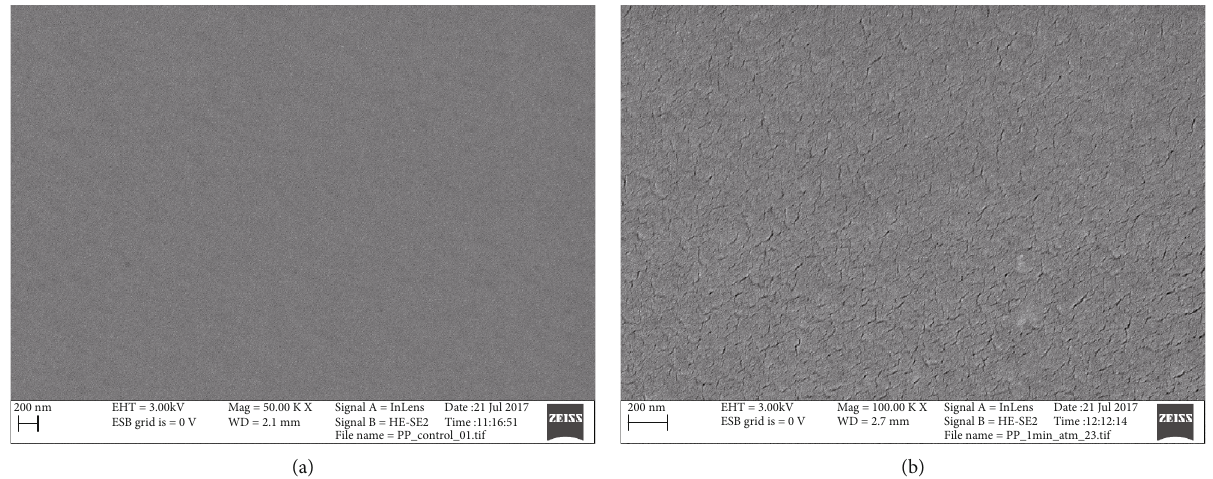
Figure 7: SEM images of untreated (a) and plasma-treated (b) samples of PP at 60 seconds.